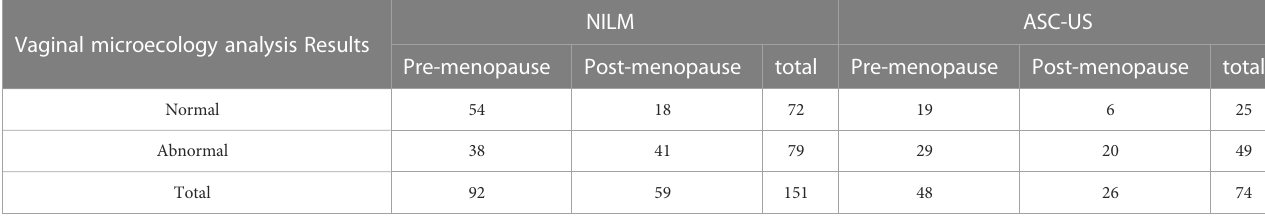
TABLE 9 Vaginal microecology analysis results for women with NILM and ASC-US.